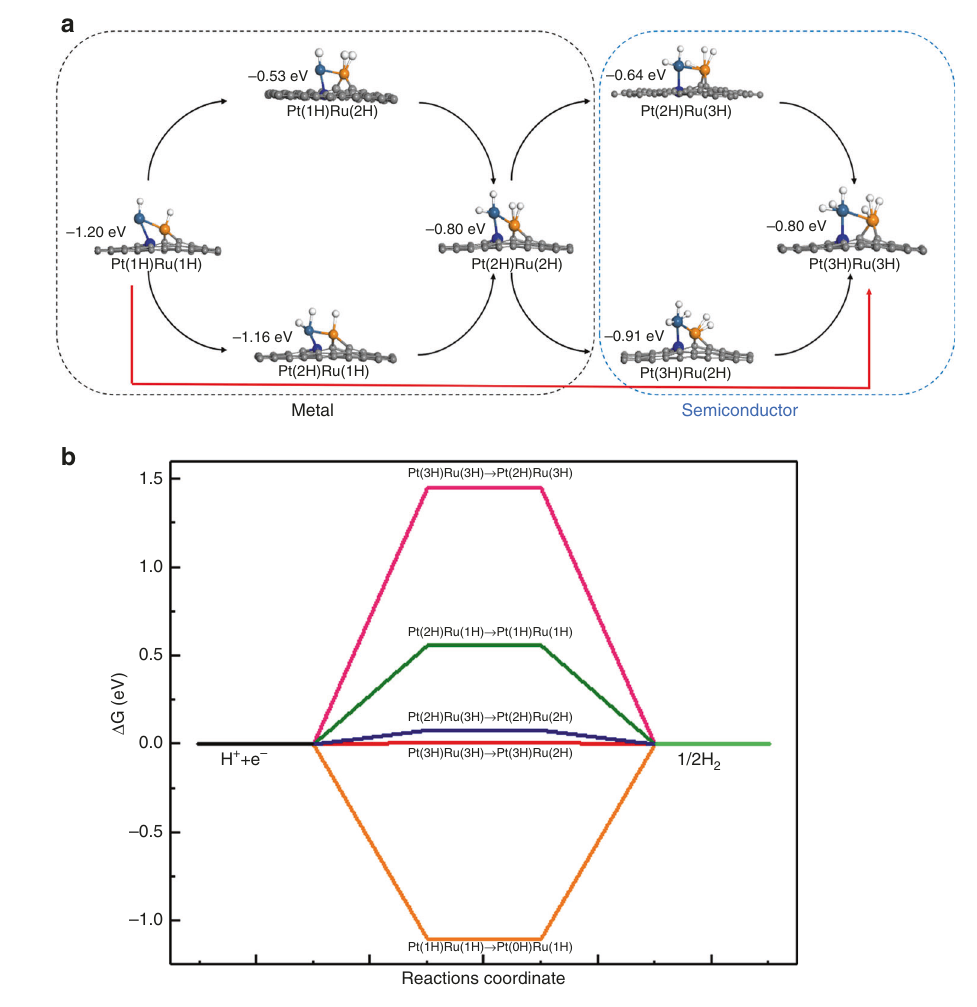
Fig. 5 Hydrogen adsorption con fi gurations on the Pt – Ru dimer and the Δ G H for different coverages of typical con fi gurations. a The atom structures of different H adsorption along with the adsorption energies. b The schematic of Δ G H for the different hydrogen coverages of typical con fi gurations. For each coverage, all the possible pathways were considered, and the lowest Δ G H for each coverage was typically shown, except we noted. Here, Pt(nH)Ru(mH) represents n H atoms adsorbed on Pt and m H atoms on Ru. Orange, dark blue, light blue and gray balls represent the Ru, Pt, N and C atoms,